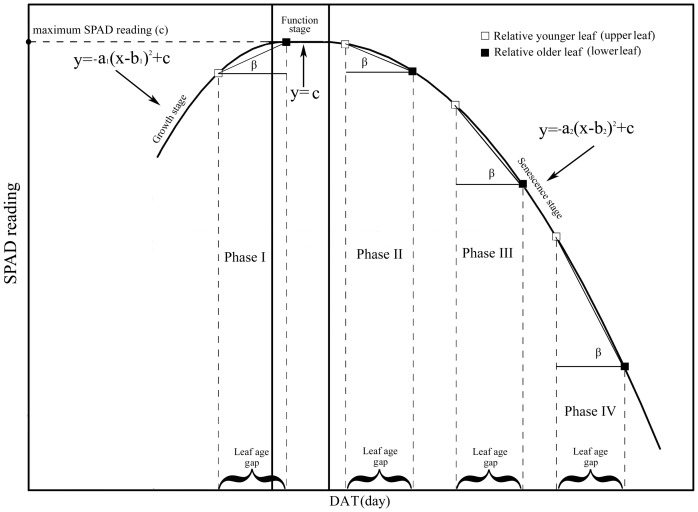
Temporal dynamics of SPAD readings over leaf lifespan fitted to a piecewise function.Leaf lifespan was divided into three growth stages: growth, function, and senescence. The leaf age difference is the difference in leaf physiological age between upper and lower leaves. The dynamics of leaf SPAD readings of upper and lower leaves were assumed to follow the same trajectory (piecewise function). Angle β served as an index of the SPAD reading distribution gradient.